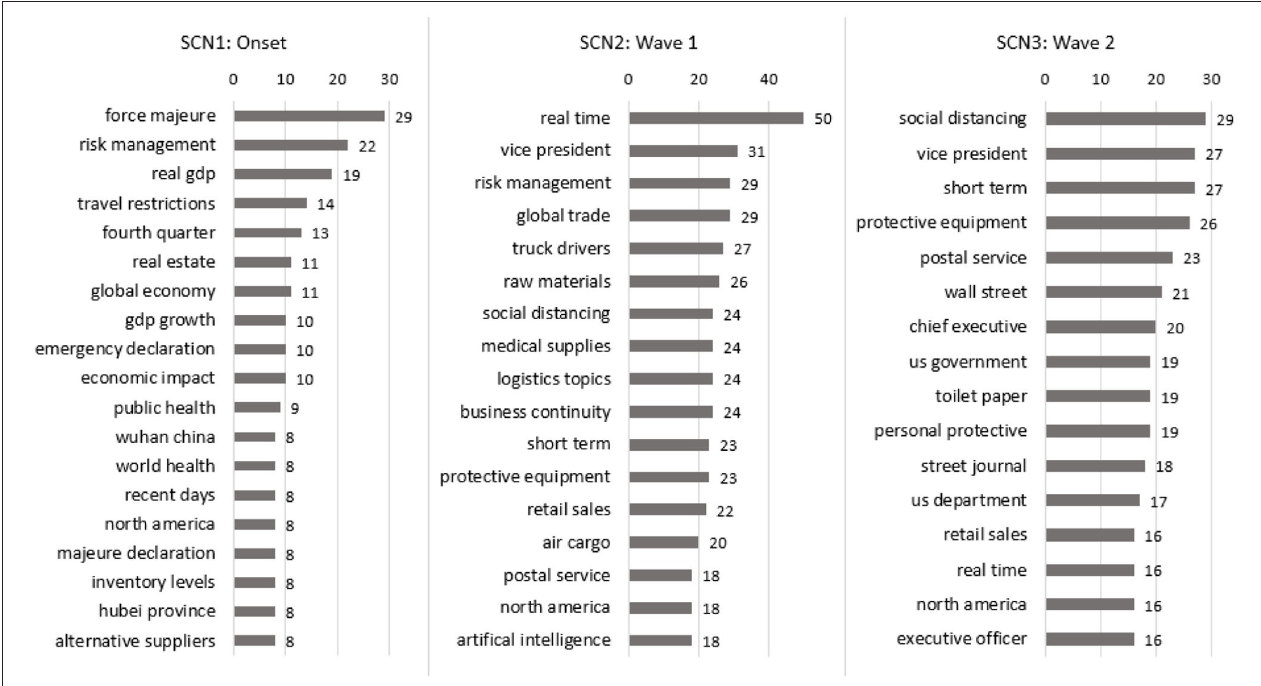
FIGURE 8 | Bigram